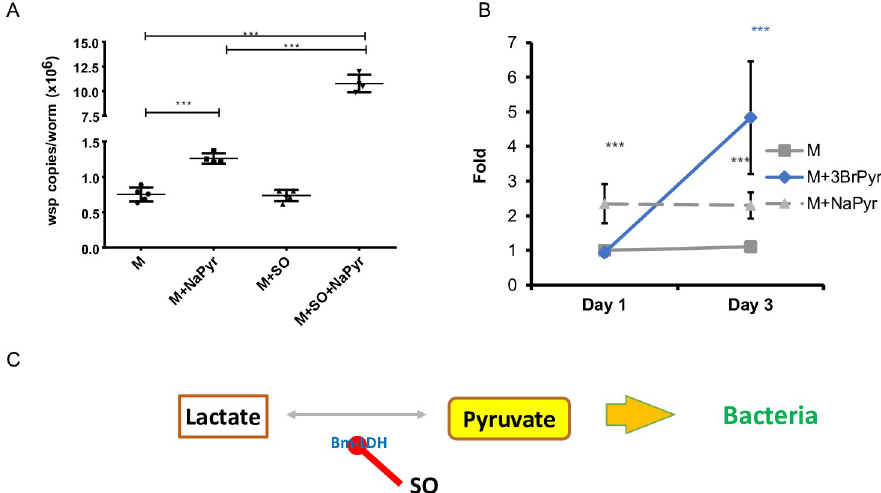
Fig 4. Effect of treatment with LDH inhibitor on the Wolbachia -parasite interaction. A. The wsp copy number per worm in adult males after a 6-day treatment was measured by qPCR ( ��� –p < 0.001). B. Relative gene expression analysis of Bm-LDH in samples treated with pyruvate (M+Pyr, grey, triangle), 3BromoPyruvate, inhibitor of glycolysis (M+3BrPyr, Blue, diamond) and control (M, gray, square). The analysis showed that pyruvate treatment induced expression of Bm-LDH after the first day of treatment. Inhibition of glycolysis only activated the expression of Bm- LDH in worms after 3 days of treatment. C. Schematic presentation of the role of Bm-LDH in pyruvate distribution between bacteria and conversion into lactate in parasite cells.